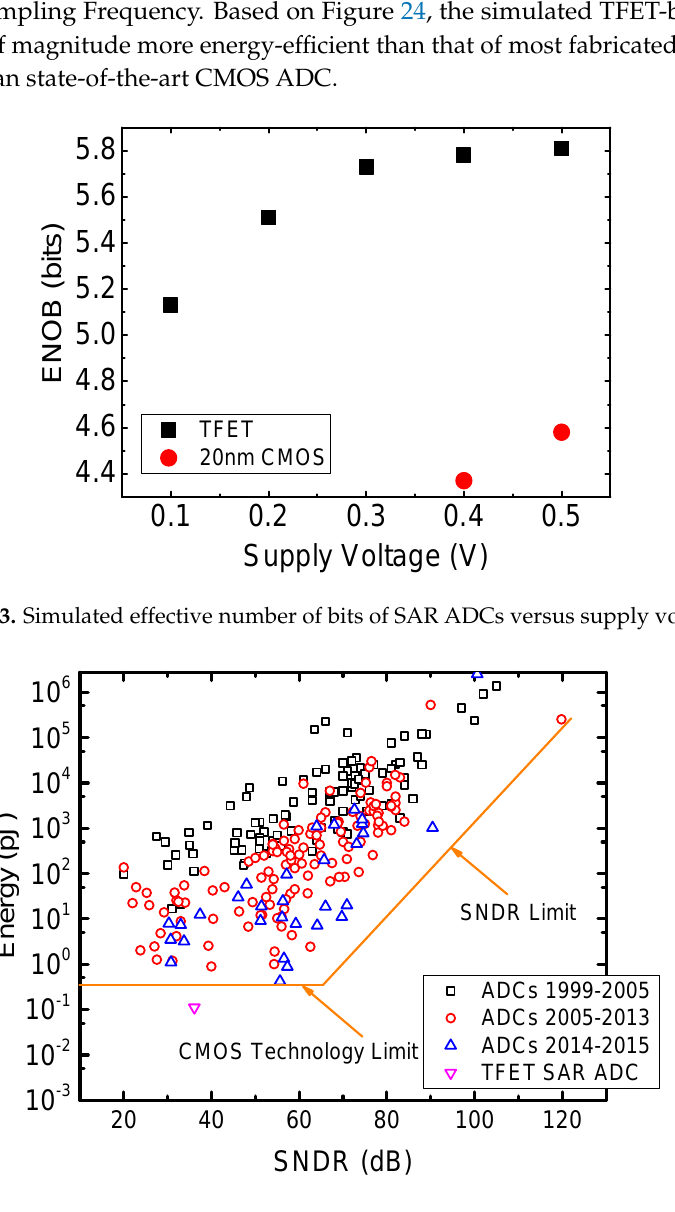
Figure 24. Energy versus signal noise dynamic range (note that the TFET SAR ADC is based on simulation results).